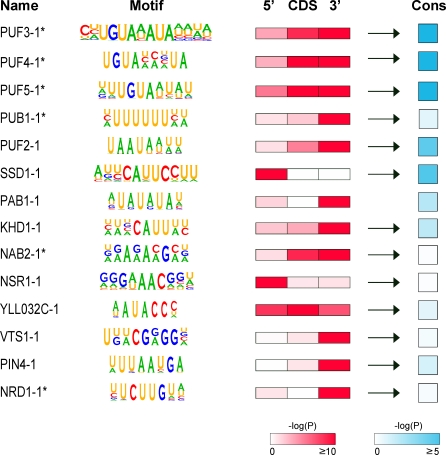
Diverse Sequence Motifs Enriched in mRNAs Bound by Specific RNA-Binding ProteinsA pictogram (http://genes.mit.edu/pictogram.html) represents the regular expression patterns defined for FIRE motifs or the preferred base composition of the position-specific scoring matrices for REFINE motifs. For each motif, the negative log10
p-value of the significance of genome-wide enrichment for motif sites in targets is represented (using a color scale) for segments of its mRNA targets (5′ = 200 bases upstream of start codon, CDS = protein coding sequence, 3′ = 200 bases downstream of stop codon). Arrows indicate motifs with a forward strand bias, i.e., the reverse complements of the motifs are not significantly enriched (p > 10−4 based on the hypergeometric distribution) in targets. “Cons” indicates the negative log10
p-value measuring whether motif sites in targets are more likely to be conserved in orthologous sequence alignments in S. bayanus than are motif sites occurring in nontargets, based on the hypergeometric distribution. Asterisks (*) denote motifs matching previously described RNA-binding elements (details in text). Exact data values and full descriptions of all motifs are presented in Table S4.